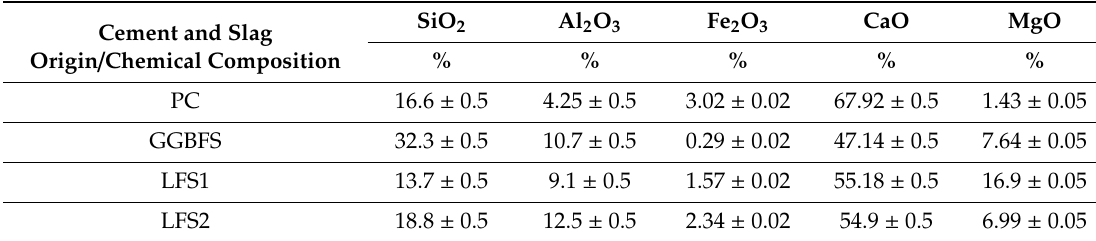
Table 1. Cement and slag chemical composition.